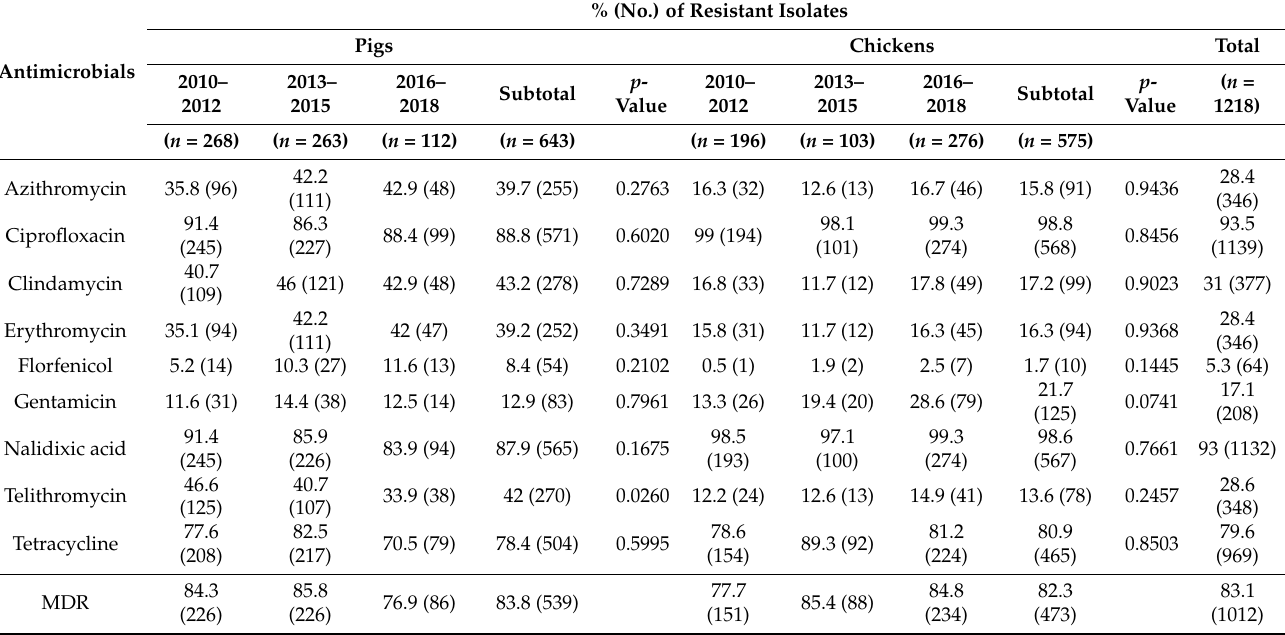
% (No.) of Resistant Isolates